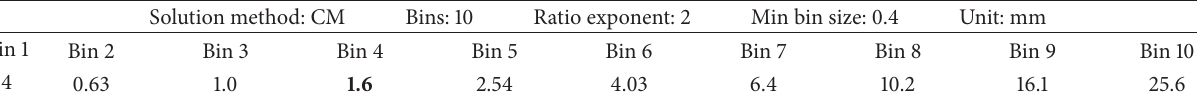
Table 1: Bin information of the solution method (CM) for PBM in the STR.